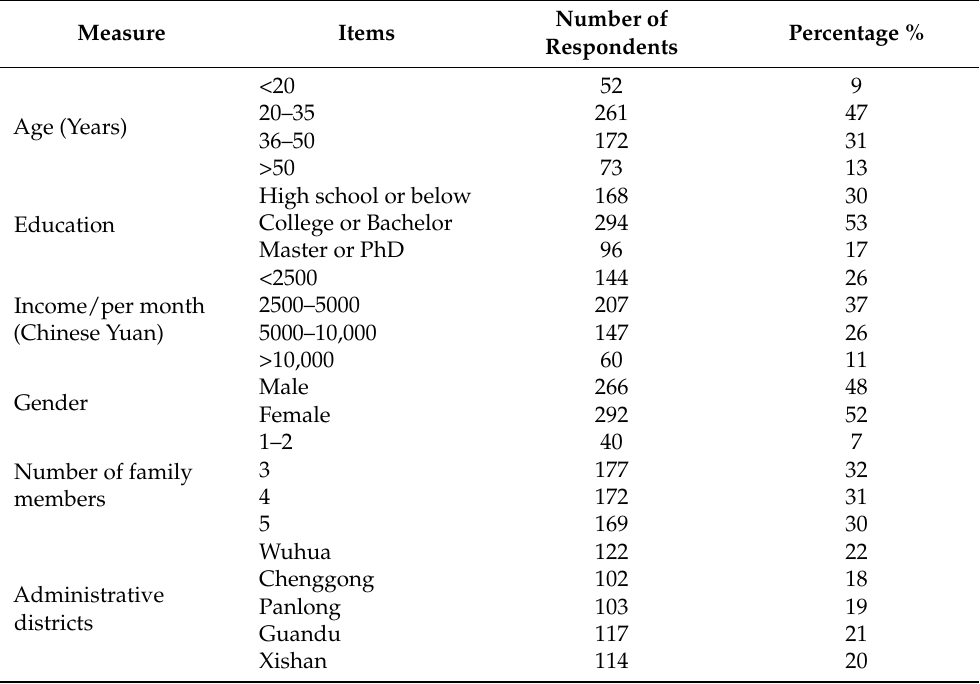
Table 1. Sample demographics ( n =